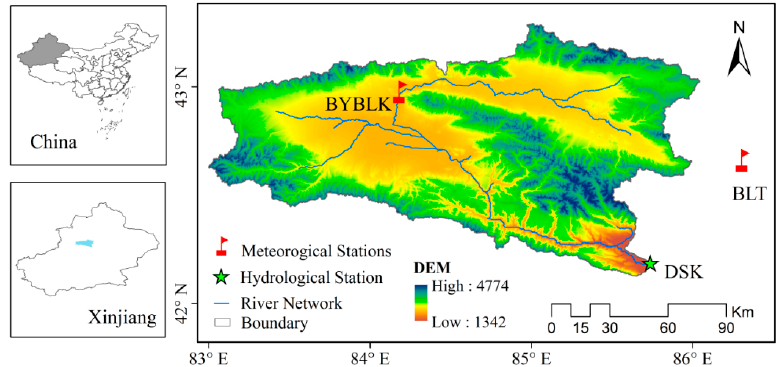
Figure 1. Locations of the Kaidu River Basin, Bayinbuluke (BYBLK) and Baluntai (BLT) meteorological stations, as well as the Dashankou (DSK) hydrological station; inset maps show the locations of Xinjiang Autonomous Region within China and the Kaidu River Basin within Xinjiang.